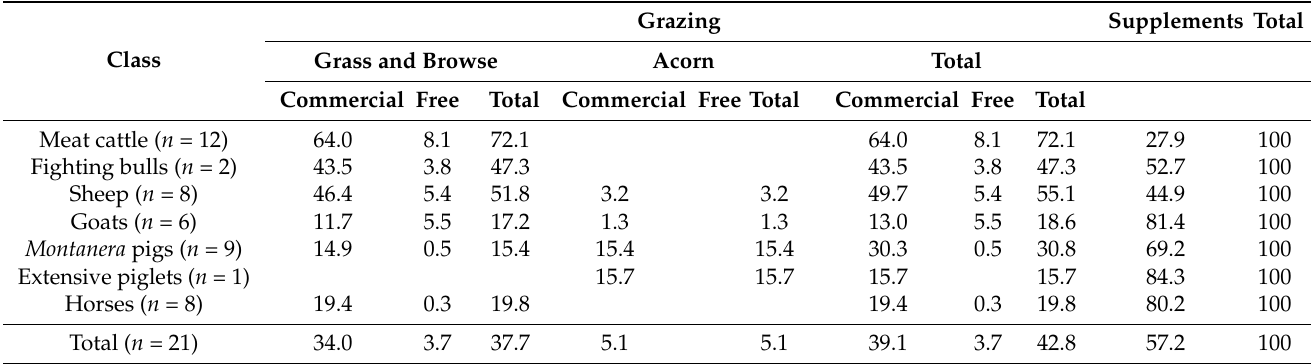
Table 3. Livestock species grazing forage unit consumption and supplements in large privately owned case-study dehesas in Andalusia (2010: %). Grazing Supplements Total